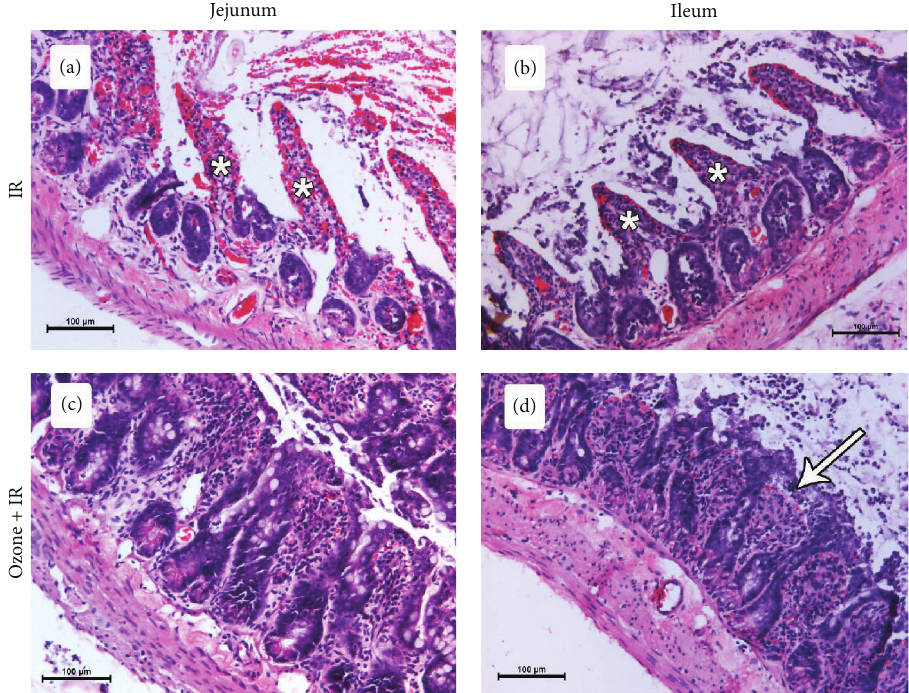
Figure 2: Effect of ischemia reperfusion and ozone pretreatment to ischemia reperfusion in jejunum and ileum (stained with hematoxylin- eosin, magnification × 200). Desquamation of the epithelium and denuded villi (asteriks) in both jejenum (a) and ileum (b) of IR group. Shortened and thick villi in both jejenum (c) and ileum (d) of ozone pretreated IR group. A less marked subepithelial space (arrow) at the villus tip in